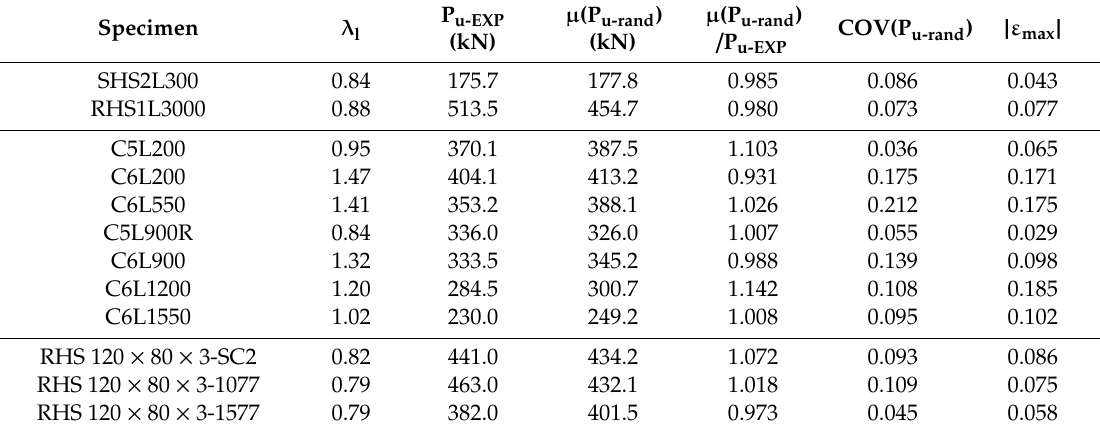
Table 3. Experimental results and predicted results for the studied columns. COV, coe ffi cients of